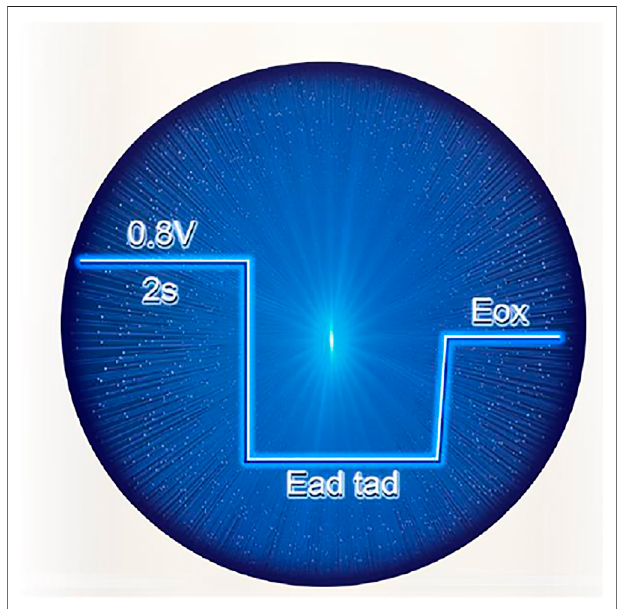
SCHEME 1 | Multi-potential step parameter.